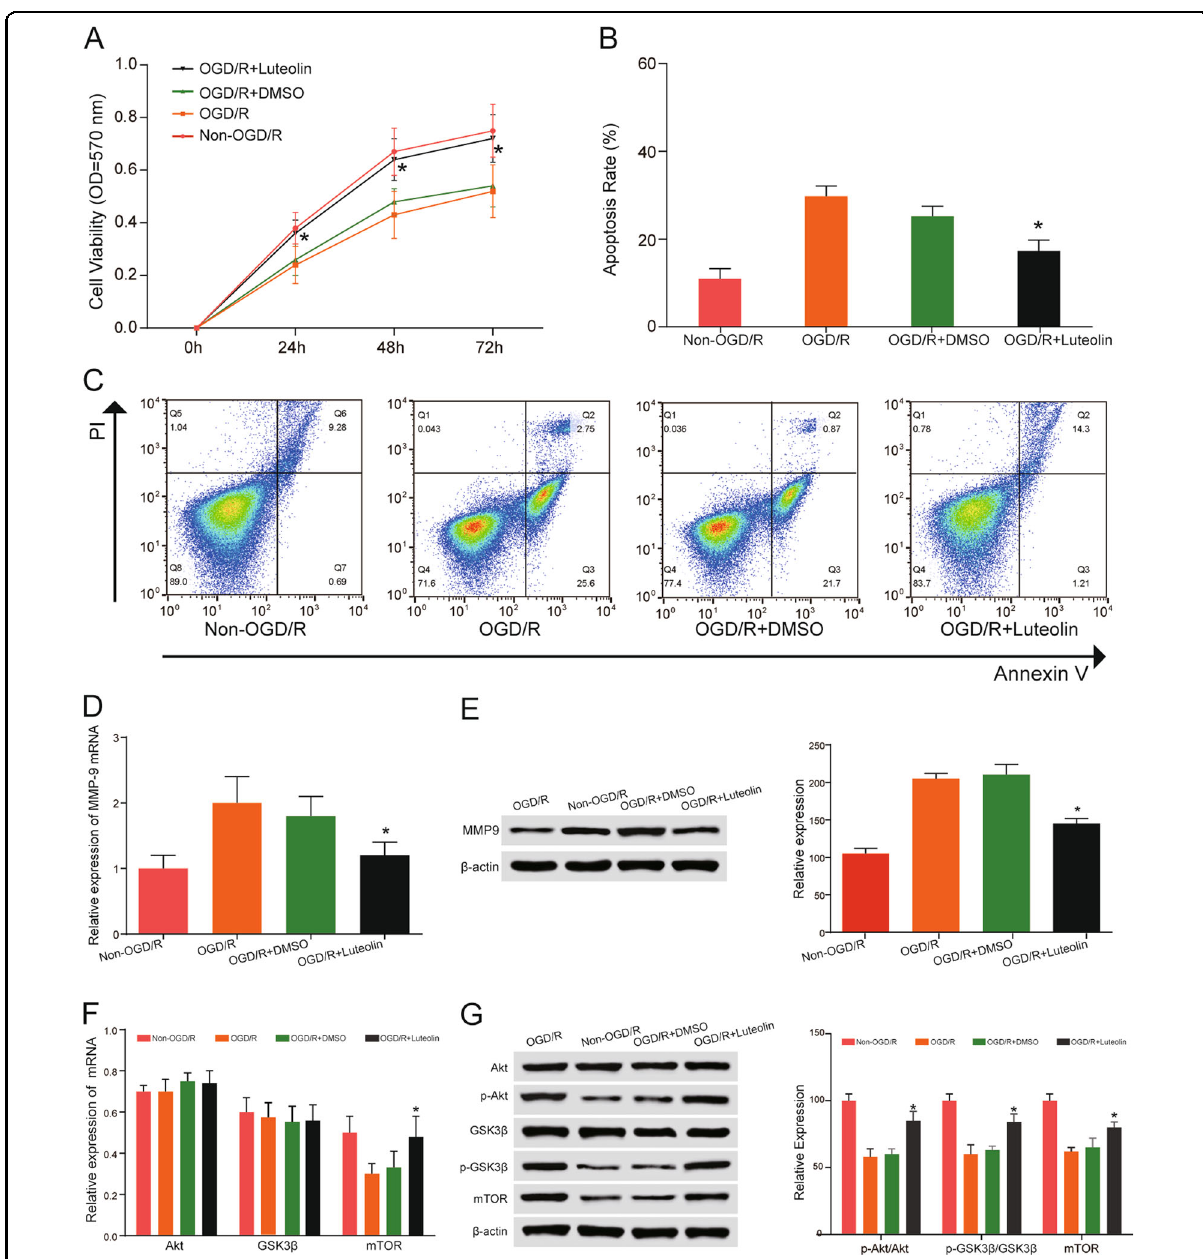
Fig. 3 Effect of luteolin on HBMECs. a The proliferation of HBMECs was assessed in the MTT experiment. The results showed that OGD/R can inhibit their proliferation, while luteolin treatment can promote their proliferation. b , c The apoptosis of HBMECs was assessed by fl ow cytometry, and the results showed that OGD/R can enhance apoptosis, while apoptosis was downregulated upon luteolin treatment. * P < 0.05, compared with the same time-point in the OGD/R group. d The mRNA of MMP9 was detected by qRT-PCR, and the results showed that luteolin enhances the mRNA of MMP9 . * P < 0.05, compared with the OGD/R group. e The protein levels of MMP9 could be suppressed by luteolin. * P < 0.05, compared with the same time- point in the OGD/R group. f The expression levels of PI3K/Akt signaling pathway mRNAs were upregulated and activated by luteolin. * P < 0.05, compared with the same time-point in the OGD/R group. g The protein levels of the PI3K/Akt signaling pathway proteins were upregulated and activated by luteolin. * P < 0.05, compared with the same time-point in the OGD/R